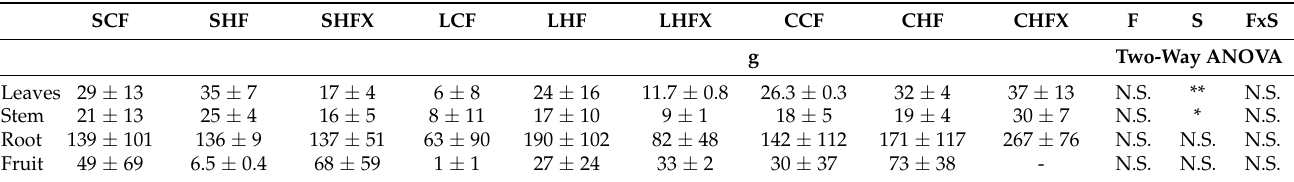
Table 3. Fresh weight of leaves, stem, root, and fruit of Capsicum annum L. grown in the sandy loam (S), clay loam (L) and clay (C) soils using the nutrient solutions: conventional fertilization (CF), MCT ® fertilizers (HF) and MCT ® fertilizers plus TX (HFX). Data are presented in grams as the mean ± standard deviation ( n = 3). Two-way ANOVA was performed to evaluate the effect of fertilization (F) and soil (S) and their interaction.